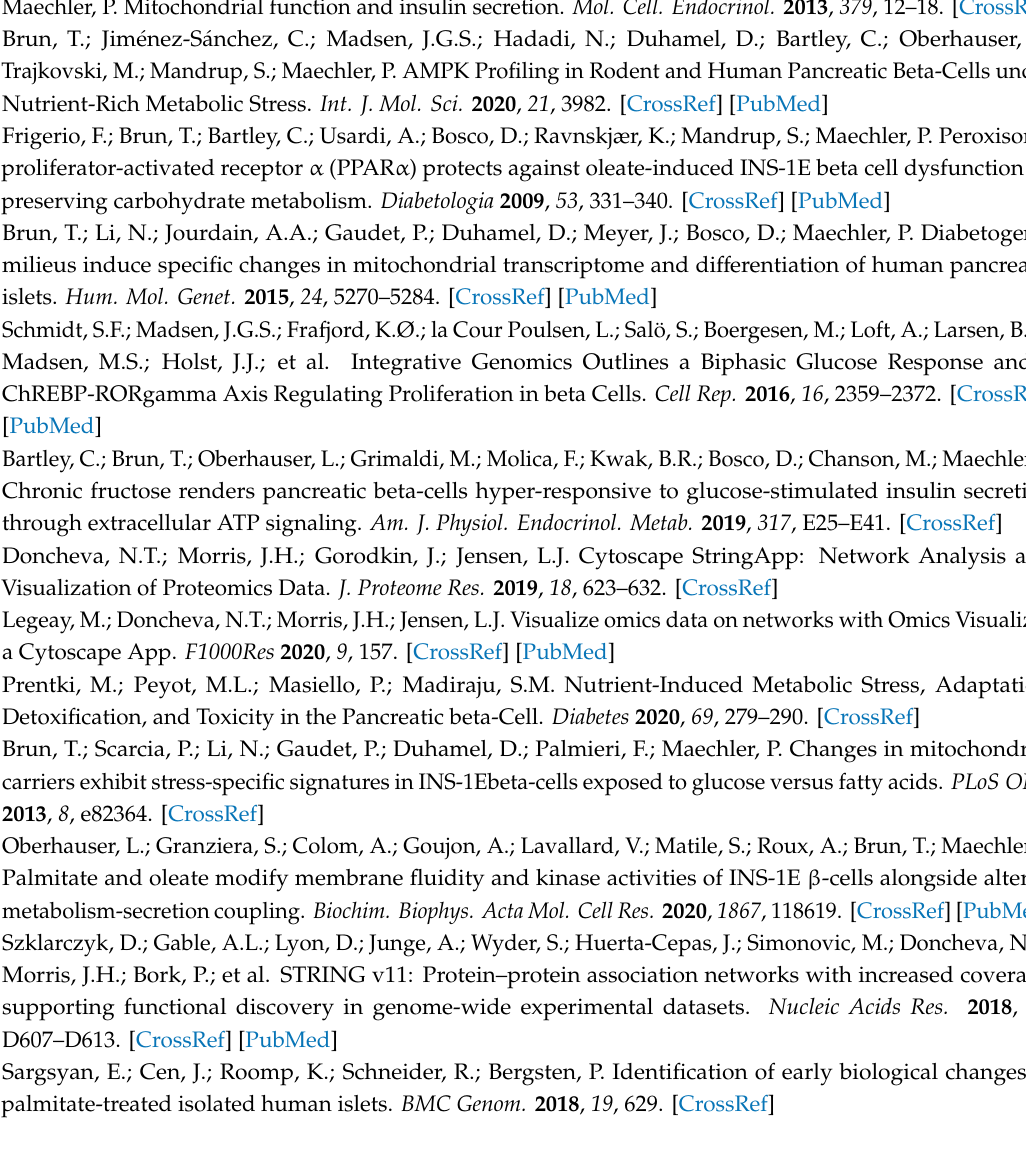
Supplementary Table S7: Primers used for quantitative RT-PCR